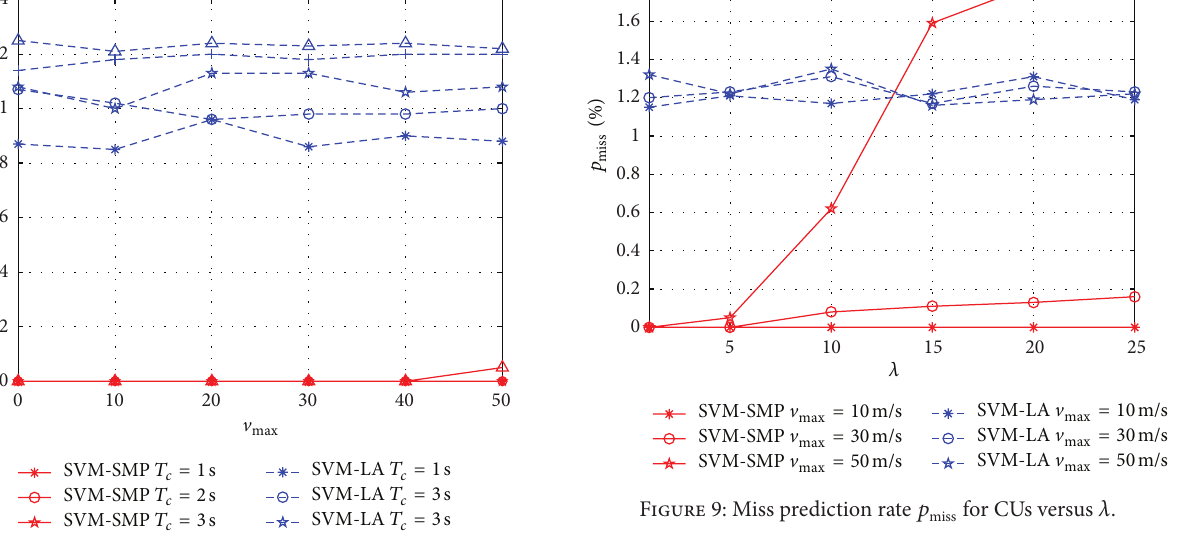
for CUs versus 𝜆 . miss